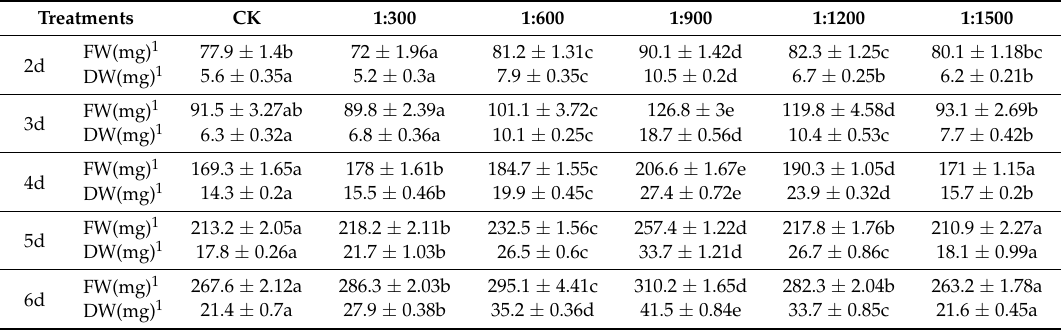
Table 2. Effect of different concentrations of wood vinegar on the FW and DW of roots of five wheat seedlings.